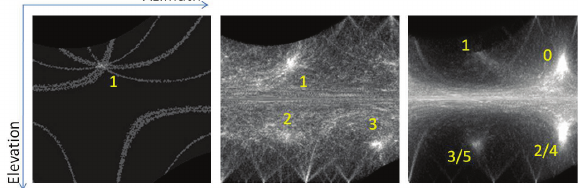
Figure 3. 2D plots (azimuth-elevation) of 3D Hough spaces for 4 points voting 1 plane (left), 120 points/3 planes (middle) and the test zone (4800 points/6 planes, right). A lighter pixel indicates a higher manifolds concentration.